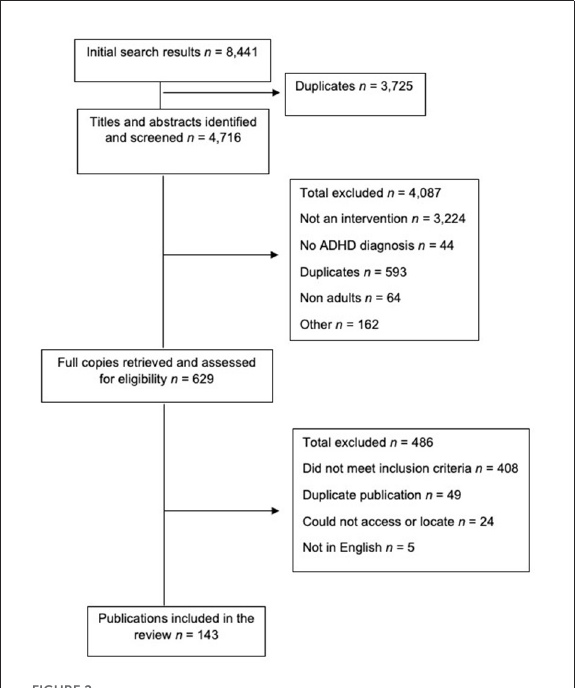
FIGURE2 Flow chart of the reviews screening process using the PRISMA